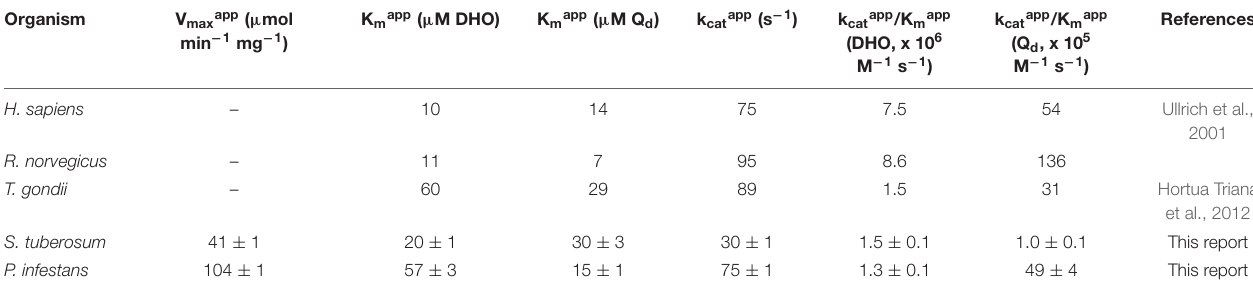
TABLE 1 | Apparent kinetic parameters of DHODHs from different organisms.